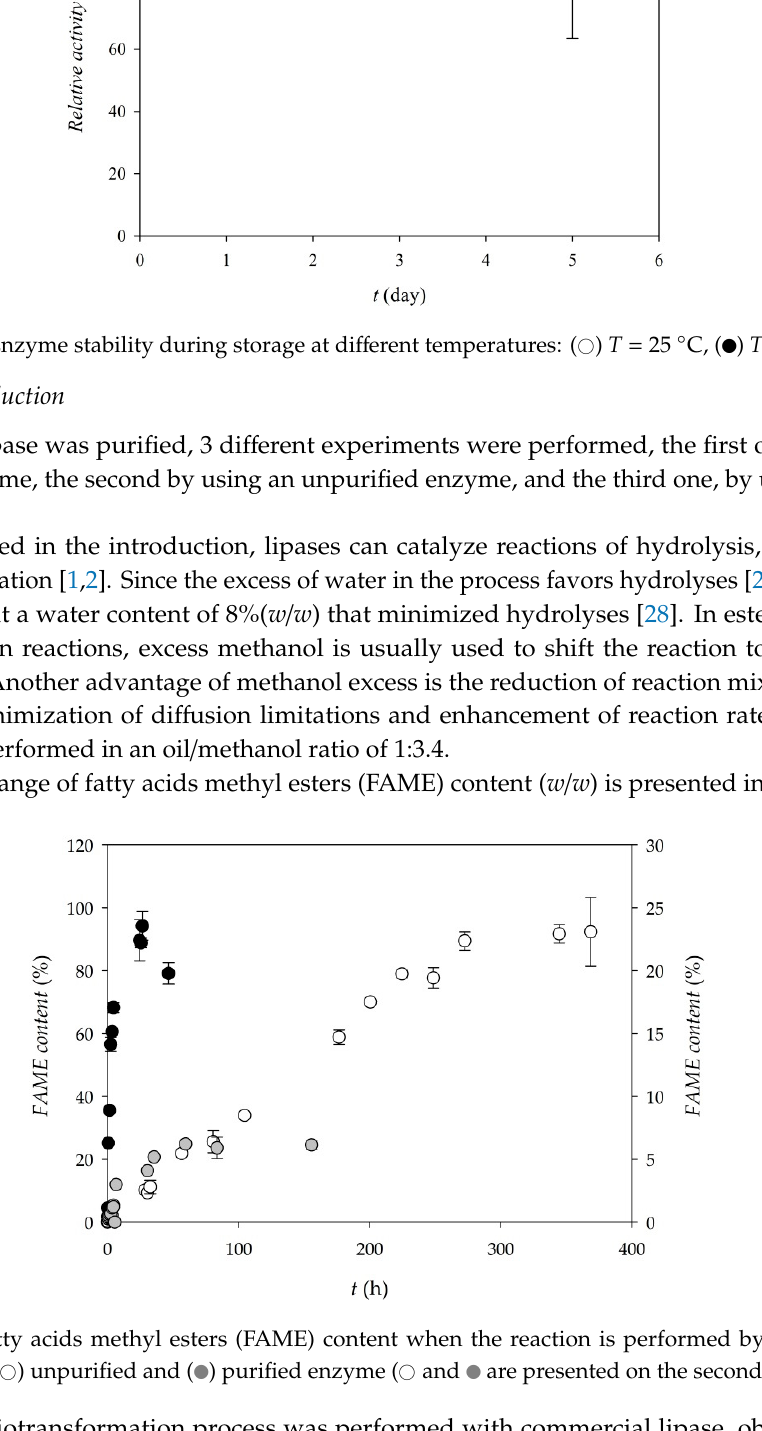
Figure 3. Enzyme stability during storage at different temperatures: ( ○ ) T = 25 °C, ( ● ) T = 4 °C .